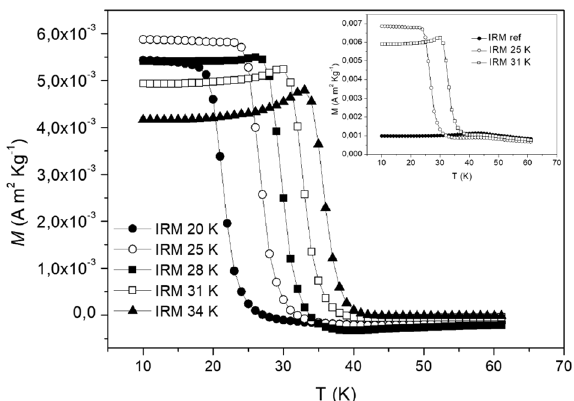
Figure 7. M IRM vs temperature using a perturbation field of 50 Oe and t h = 300 s for several halting temperatures; T h = 20, 25, 28, 31, 34 K. The data was corrected for a background contribution, as illustrated in the inset. The inset shows the magnetization data without correction at T h = 25 K and 31 K as well as the reference background measurement, denoted IRM ref, in which the system is cooled and measured in zero applied magnetic